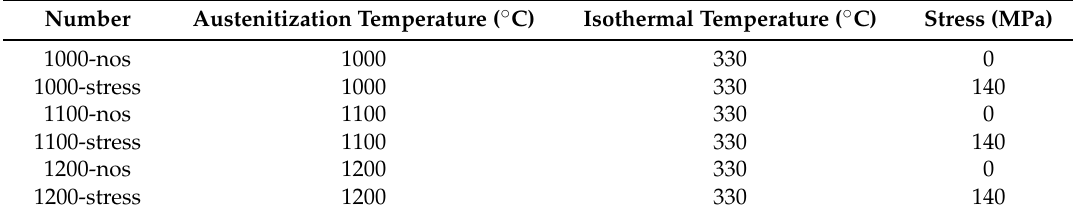
Figure 2. An illustration of the experimental procedure. Table 1. The numbers of experimental specimens corresponding to different thermal simulation parameters.